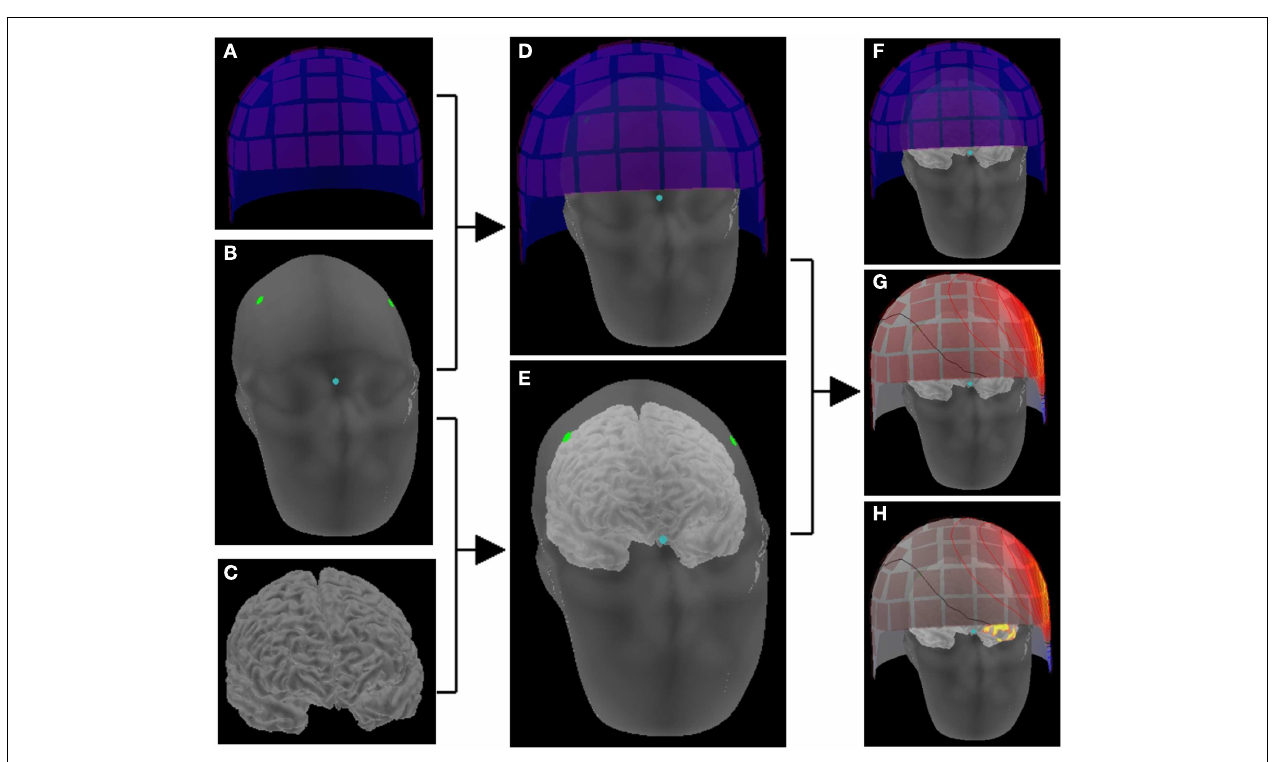
on the reconstructed images of MRI (E) .Thus, the brain and the sensor array are co-registered (F) , and magnetic fields on the sensor space provides activation maps on the source space (G) that consists of the cortical surface (H) .